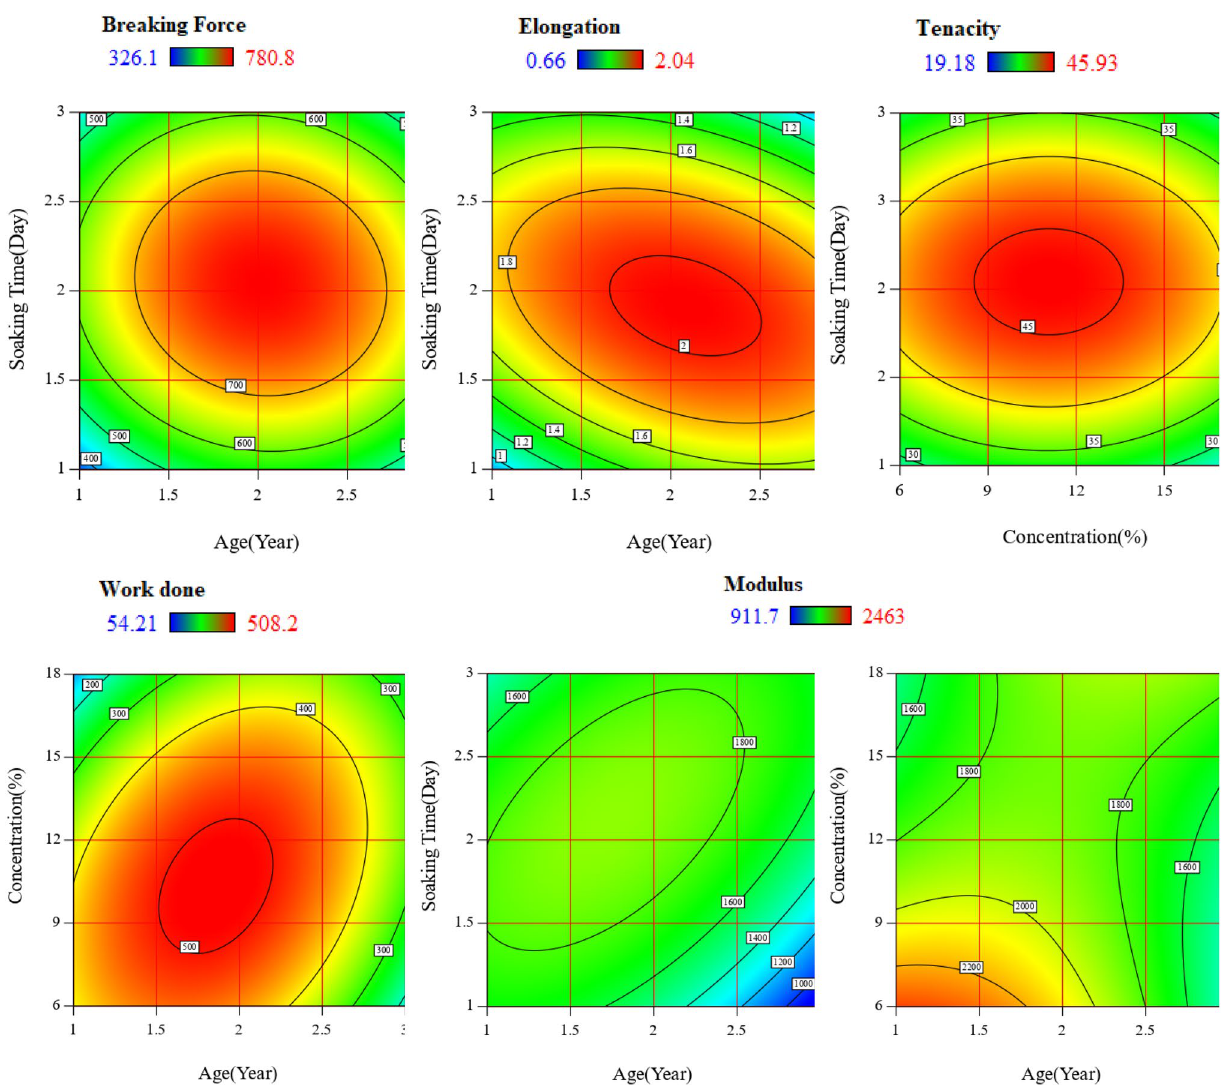
Fig. 11 2D plots of concentration versus plant age, soaking time versus plant age, and concentration versus soaking time on tested mechanical